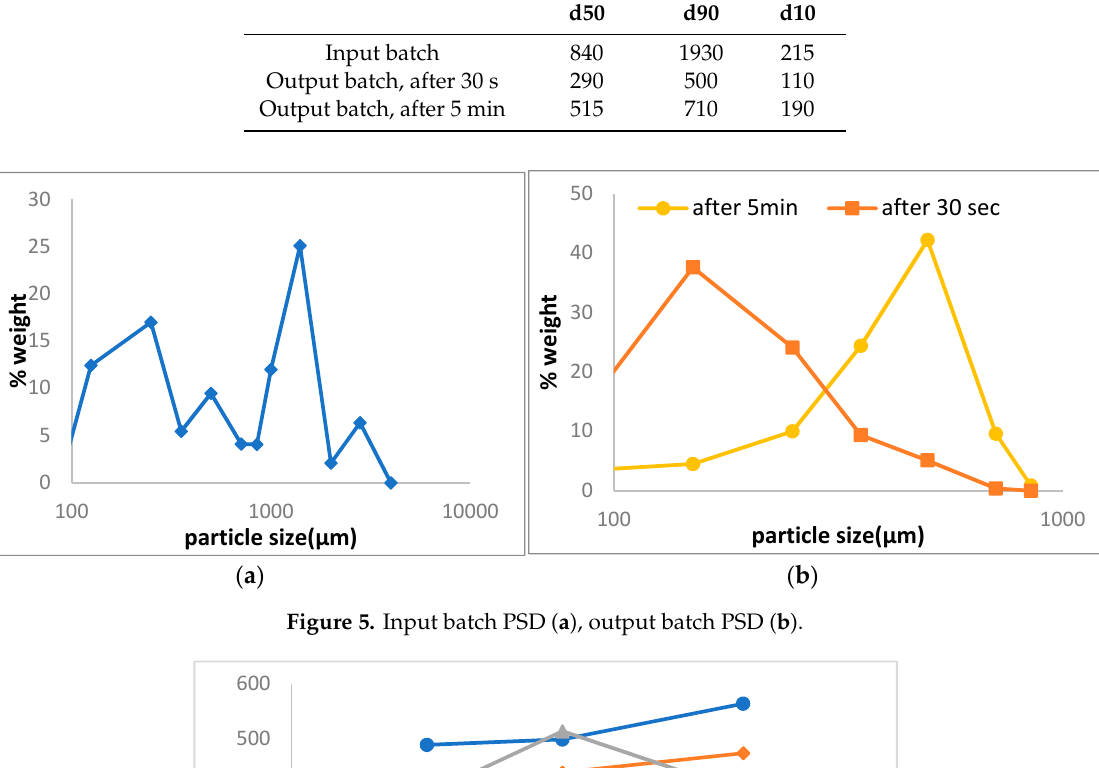
Figure 5. Input batch PSD ( a ), output batch PSD ( b ).